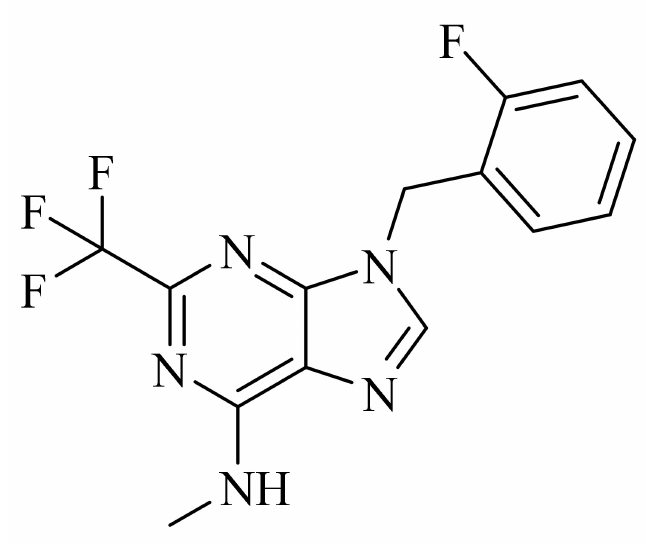
Figure 5. Structure of compound NCS613 (preclinical study for